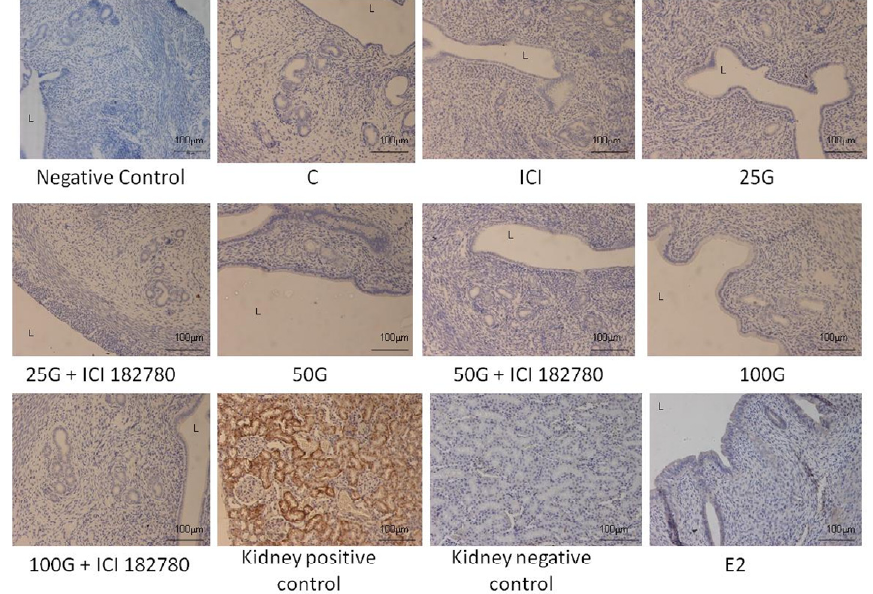
Figure 10. The distribution of NBCe1-A in the uterus of rats treated with various doses of genistein (25, 50 and 100 mg/kg/day with and without the presence of ICI 182780, an estrogen receptor antagonist). NBCe1-A was not expressed in the uterus following genistein treatment. The kidney was used as a positive control where intense immunostaining was seen at the basolateral membrane. Low staining intensity was seen at the apical membrane of the luminal epithelia following estrogen treatment. C: control; ICI: ICI 182780; 25G: 25 mg/kg/day genistein; 50G: 50 mg/kg/day genistein; 100G: 100 mg/kg/day genistein; E2: estrogen. n = 4 rats per group. The images were taken at 20× magnification. L: